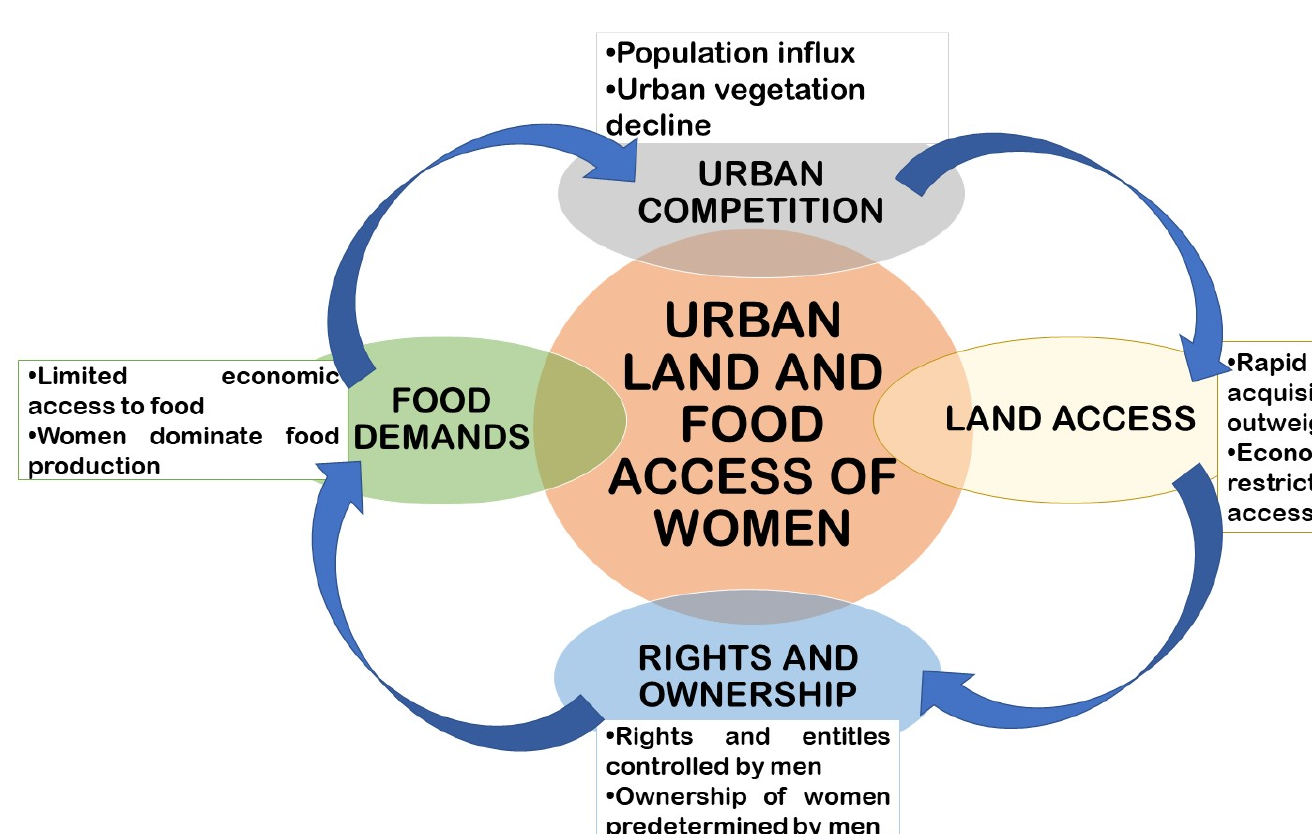
Figure 1. Conceptual framework of land-gender nexus in Ghana (author’s